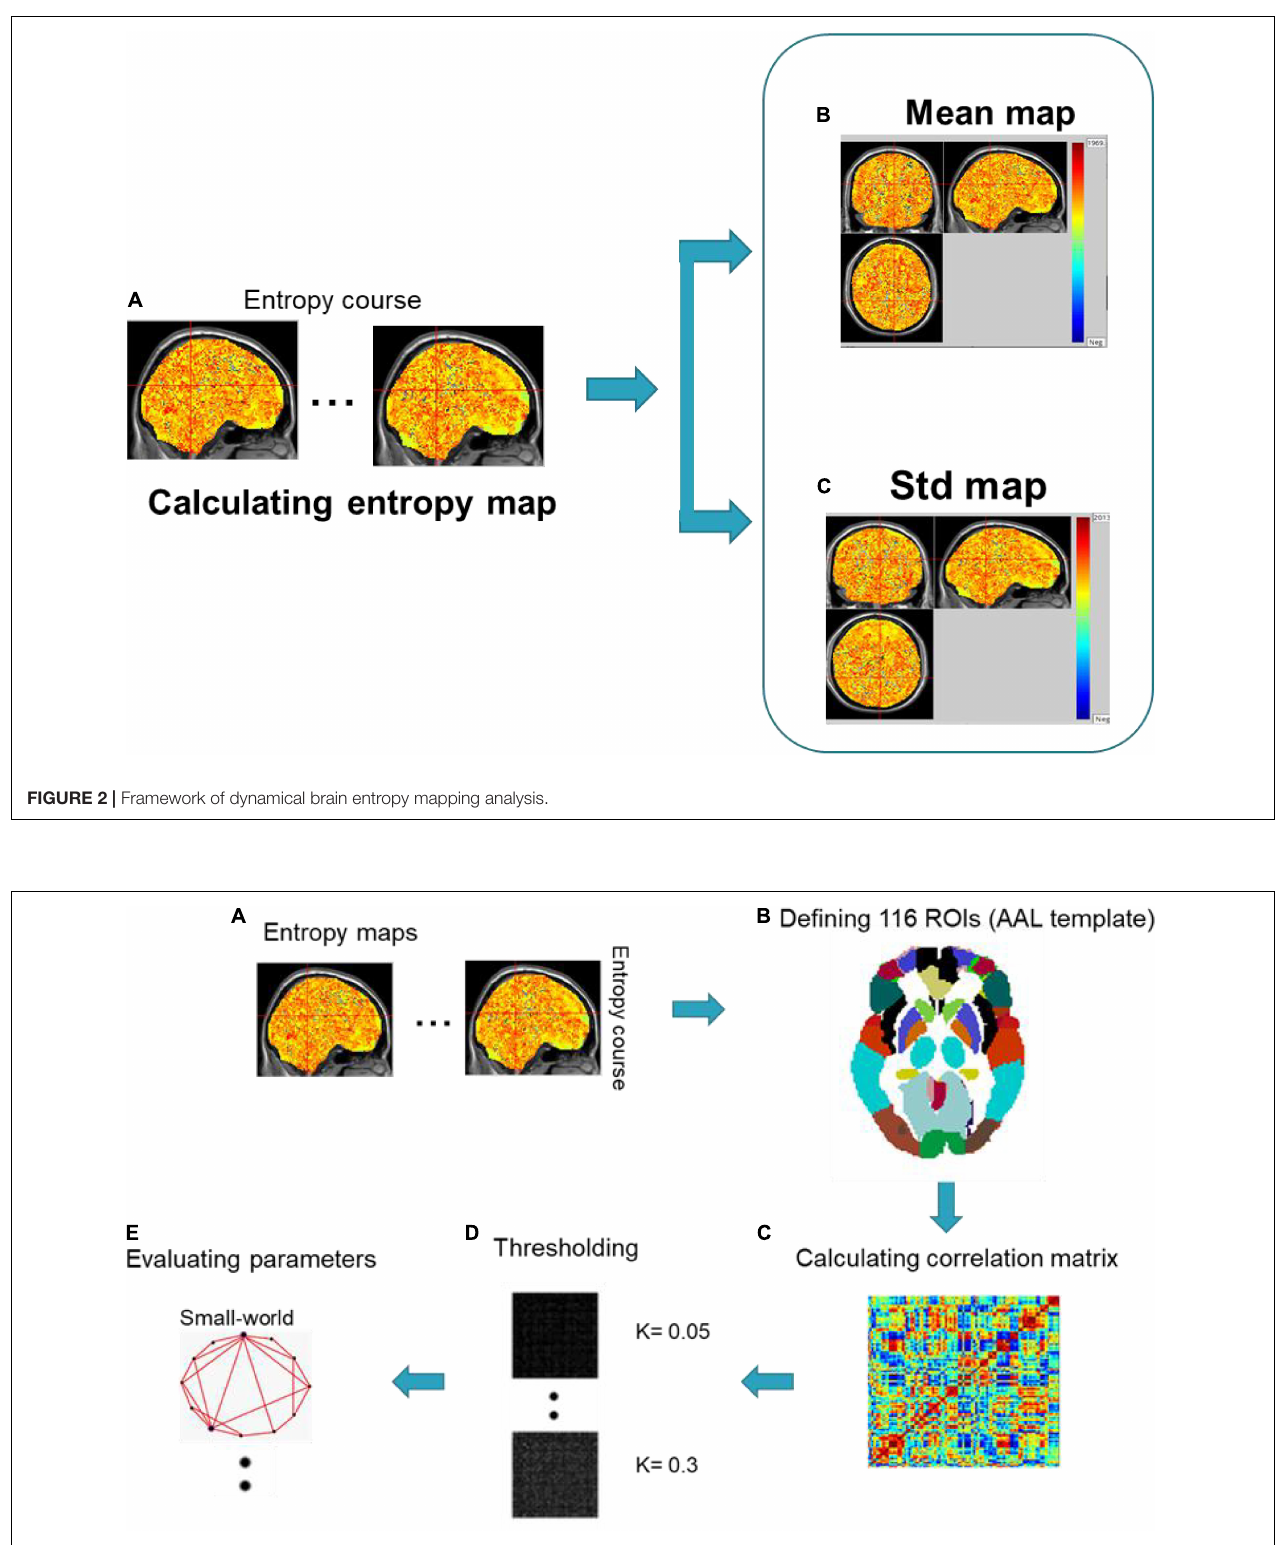
Frontiers in Neuroscience |